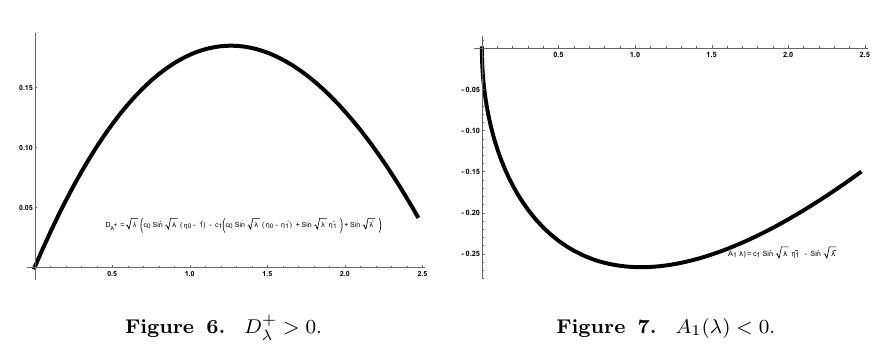
Figure 5. λ = 0 . 1 , m = 5 .